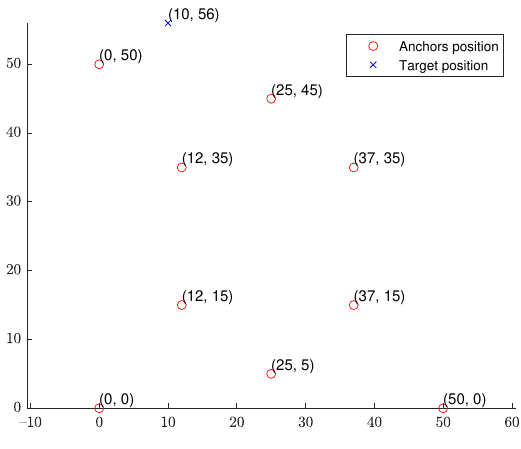
Figure 3. DRSS-AOA geometry with fixed source location.